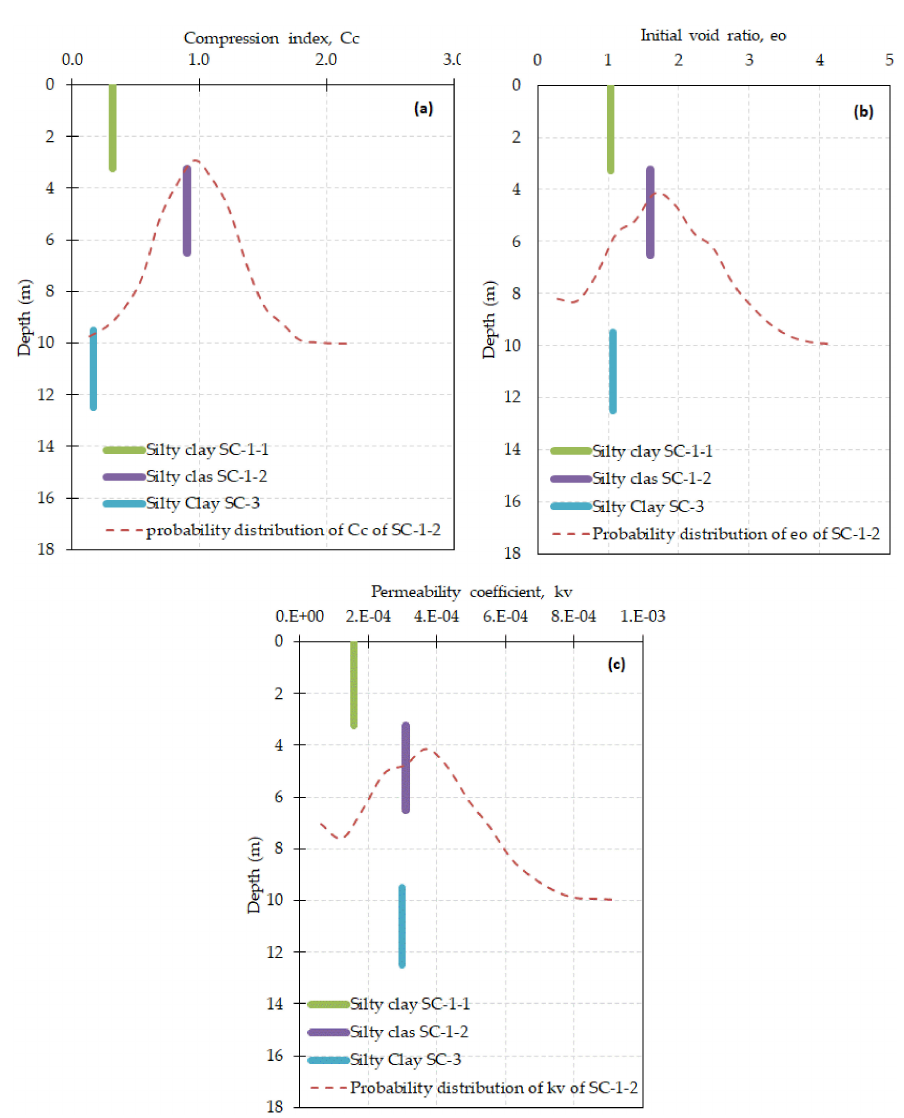
Figure 2. Mean values of model parameters for di ff erent layers and probabilistic distribution for the most influential layer (Silty clay SC-1-2) of Karakore clay ( a ) Compression index ( b ) Initial void ratio ( c ) vertical coe ffi cient of